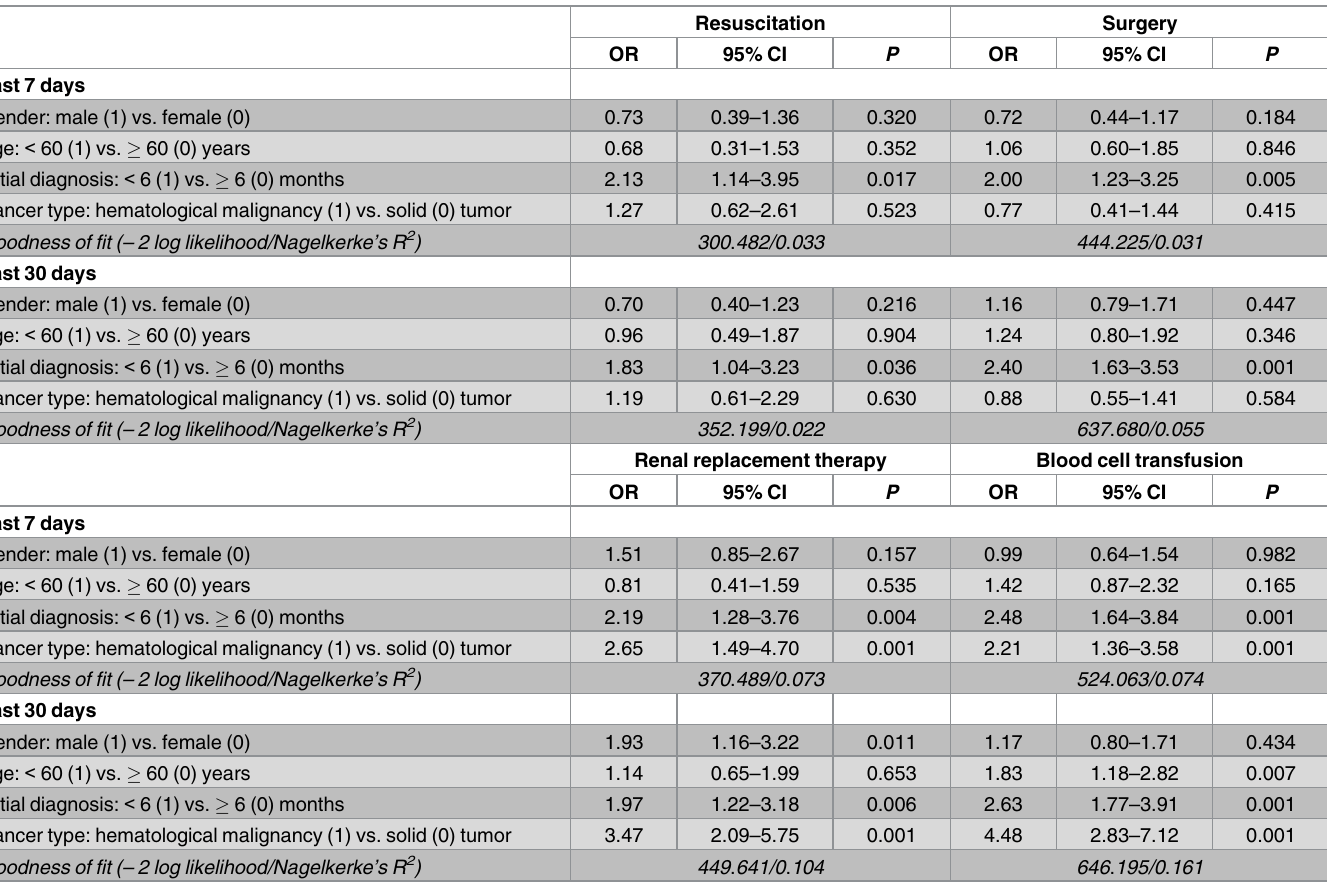
Table 8. Factors associated with aggressive cancer care at the end of